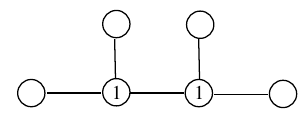
Figure 12: An antiregular dominating labeling for ˜ T